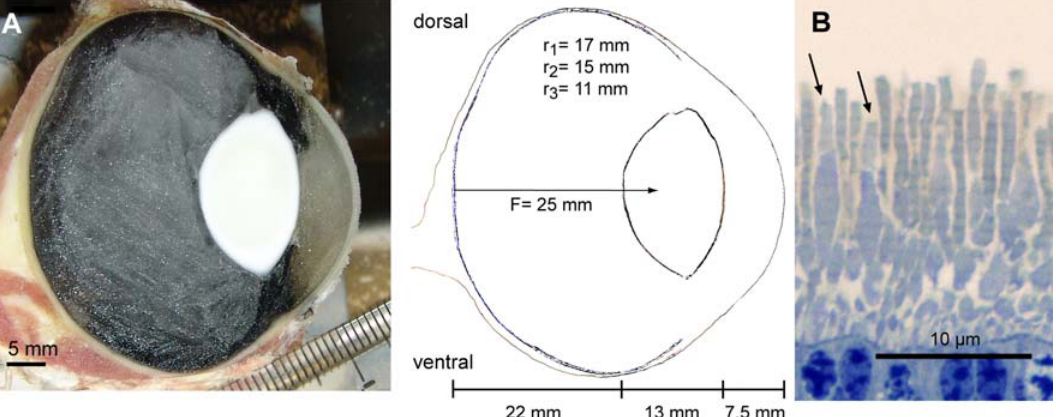
Figure 4. The distance from retina to the nodal point was 25 mm in the frozen, sagitally sectioned horse eye (A). The outer segment of the bulkier cones (B) has a diameter of 1 m m and a length of 4 m m (arrows).